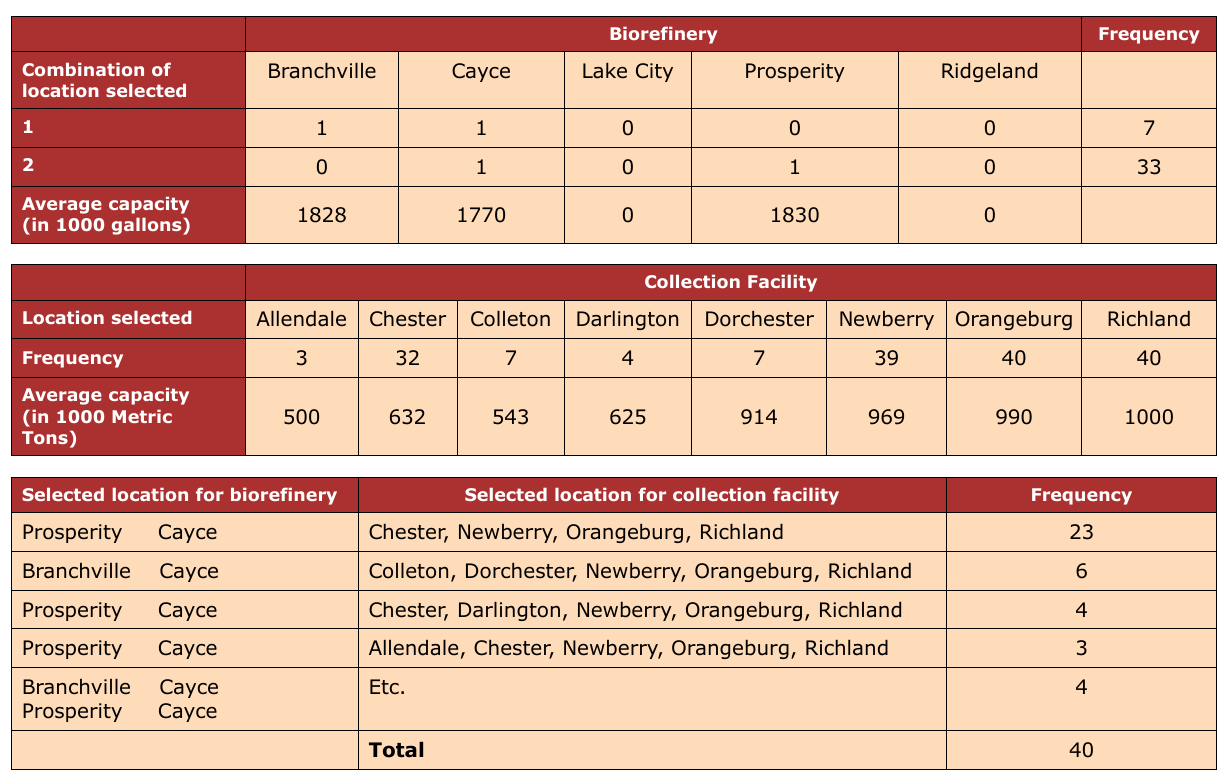
Table 2c. Simulation Results of Locations of Biorefinery and Collection Facility for Case 3 (Right-Skewed Triangle Distribution)